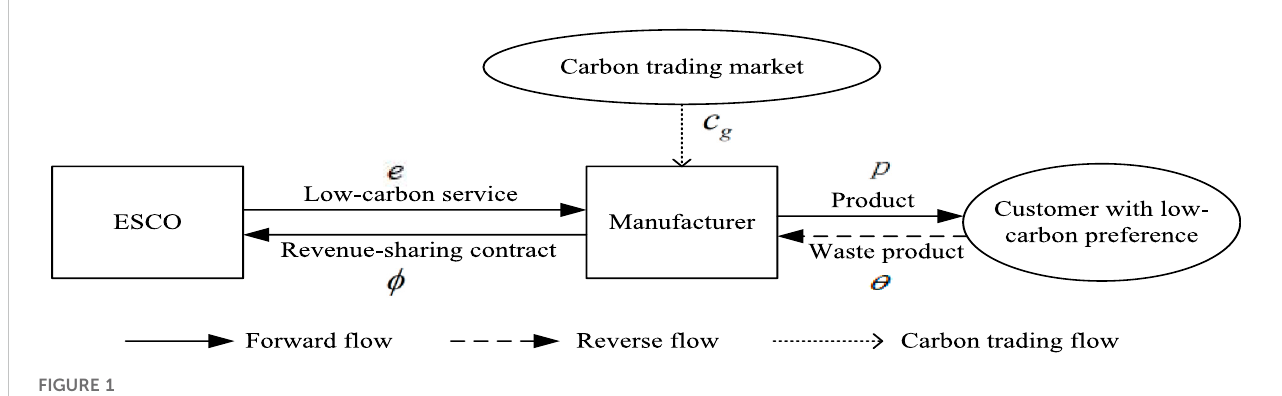
FIGURE 1 The model of the closed-loop supply chain for embedded low-carbon service.